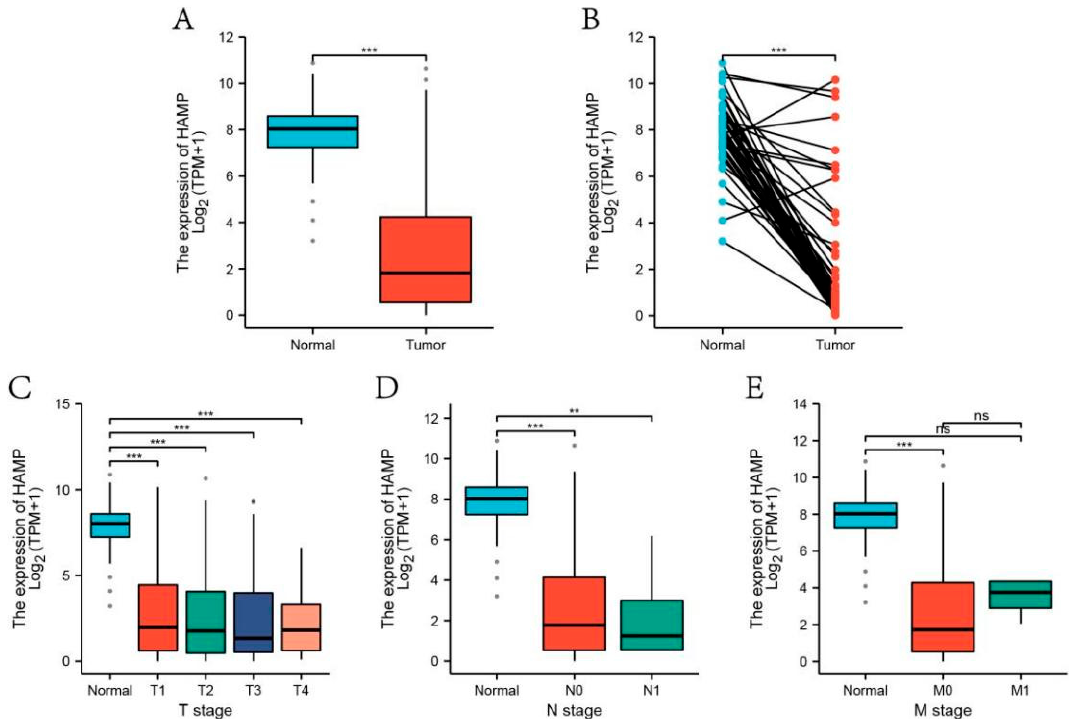
Figure 5. ( A ) Comparison of HAMP expression between HCC and normal samples. ( B ) Comparison of HAMP expression between HCC and paired normal samples. ( C – E ) Association between HAMP expression and HCC tumor stage. * p < 0.05, ** p < 0.01, *** p < 0.001.